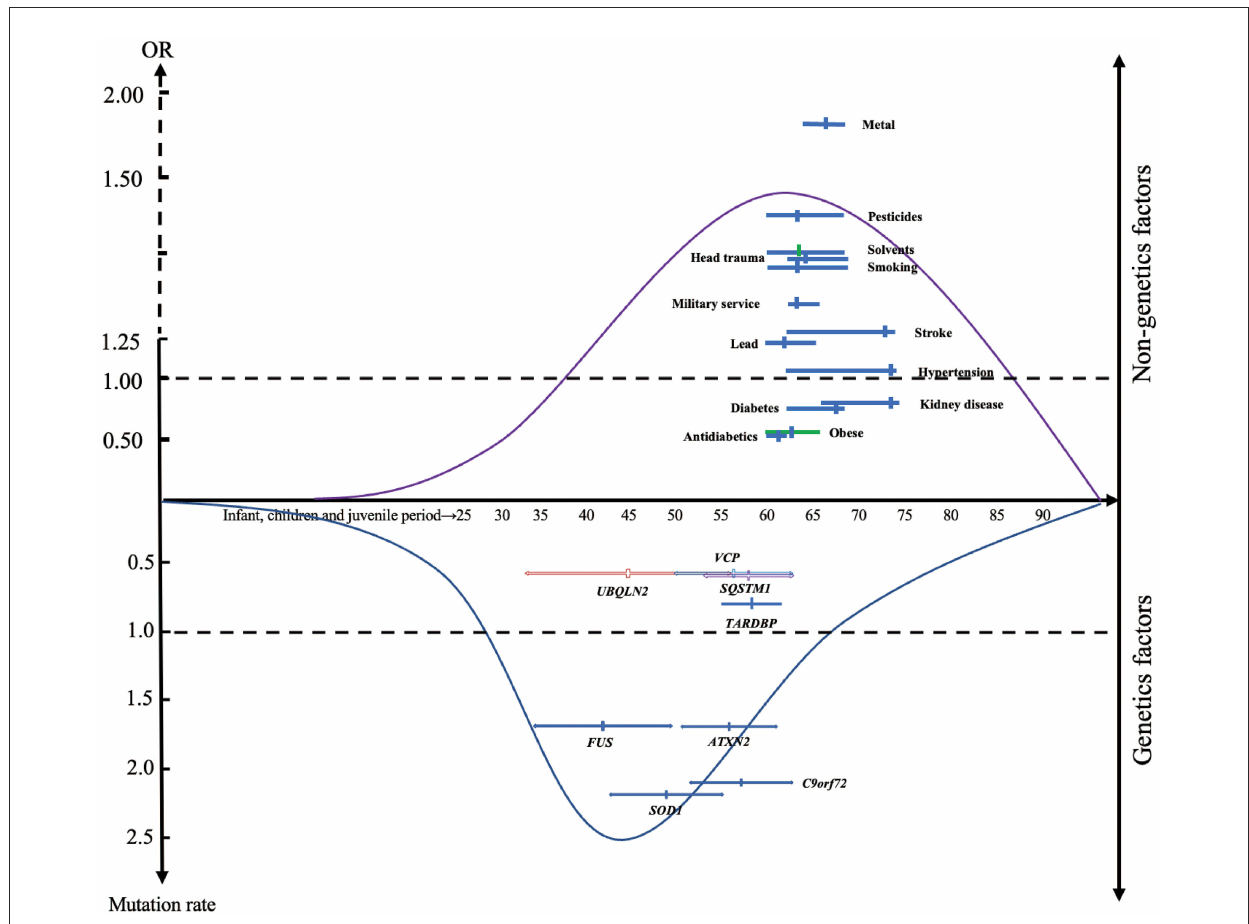
FIGURE3 The distribution of modifiable factors throughout the course of life. Suggesting that genetic factors may have a more important causative role in patients with early onset of disease than non-genetic factors. The x-axis represents the mean age of the total sample (solid circle), including the mean age range of the included studies (short horizontal line). The y-axis represents the summarized odds ratio (OR) and mutation